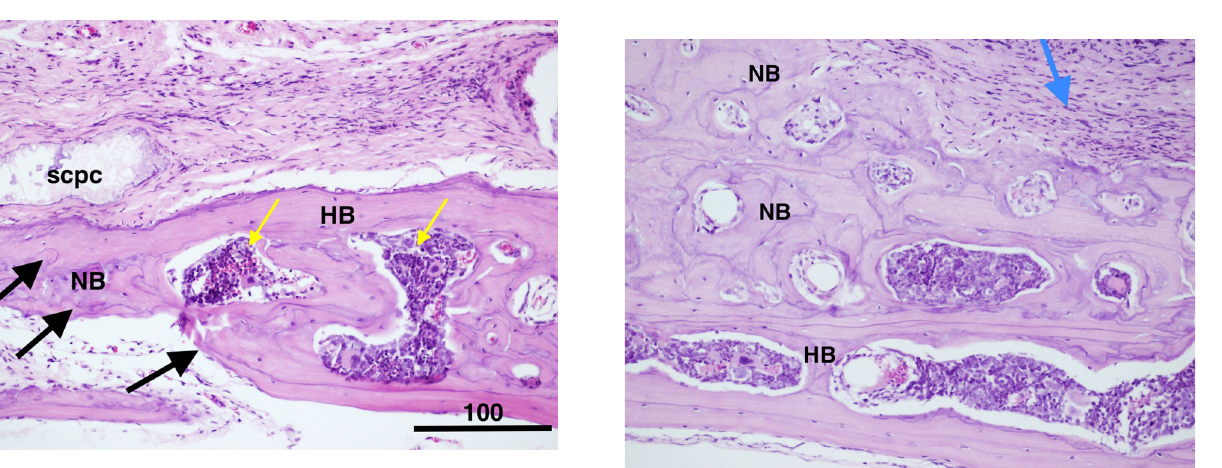
and pre-osteoblastic cells (red arrow) in the collagenous matrix with immature bone deposits (black arrow). The DSM remnant is denoted with blue arrows; the periosteum-like structure is denoted with yellow arrows, scale bar = 150 µm